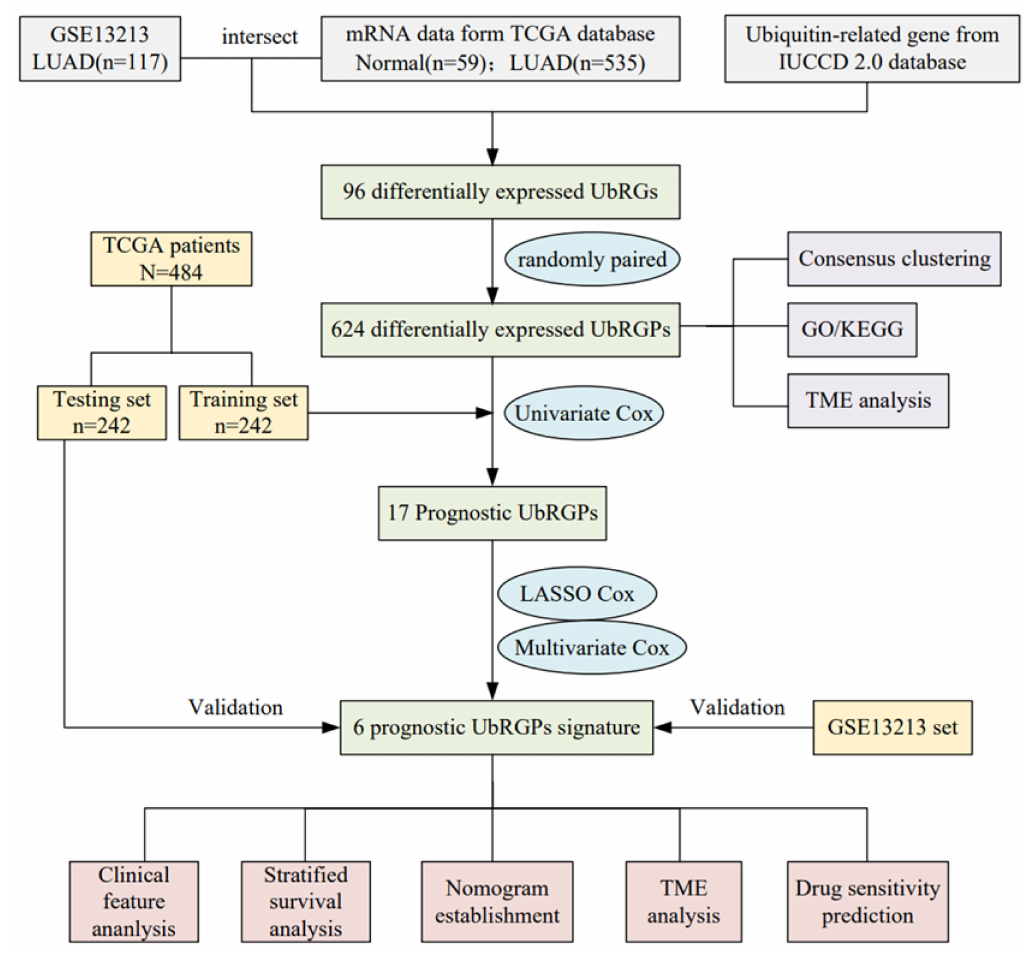
Figure 1. The flow chart of the study. Table 1. Clinicopathological features of the patients in TCGA–LUAD cohort and GSE13213